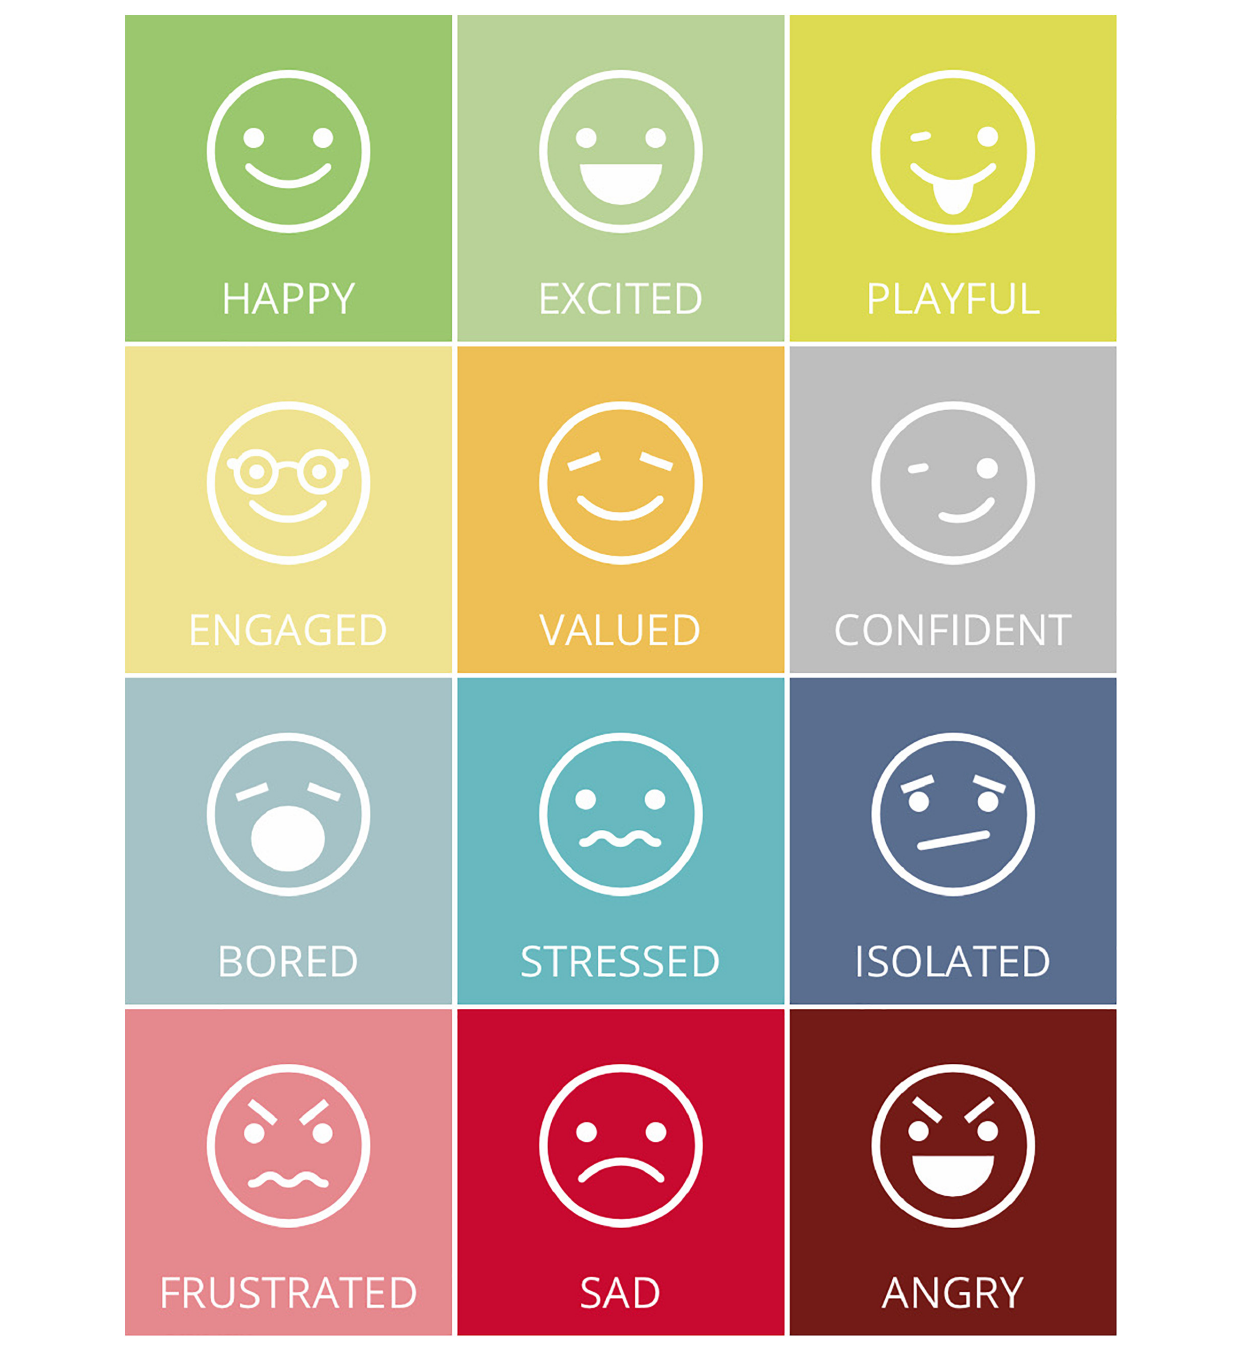
FIGURE 1 | Set of emotions presented by the